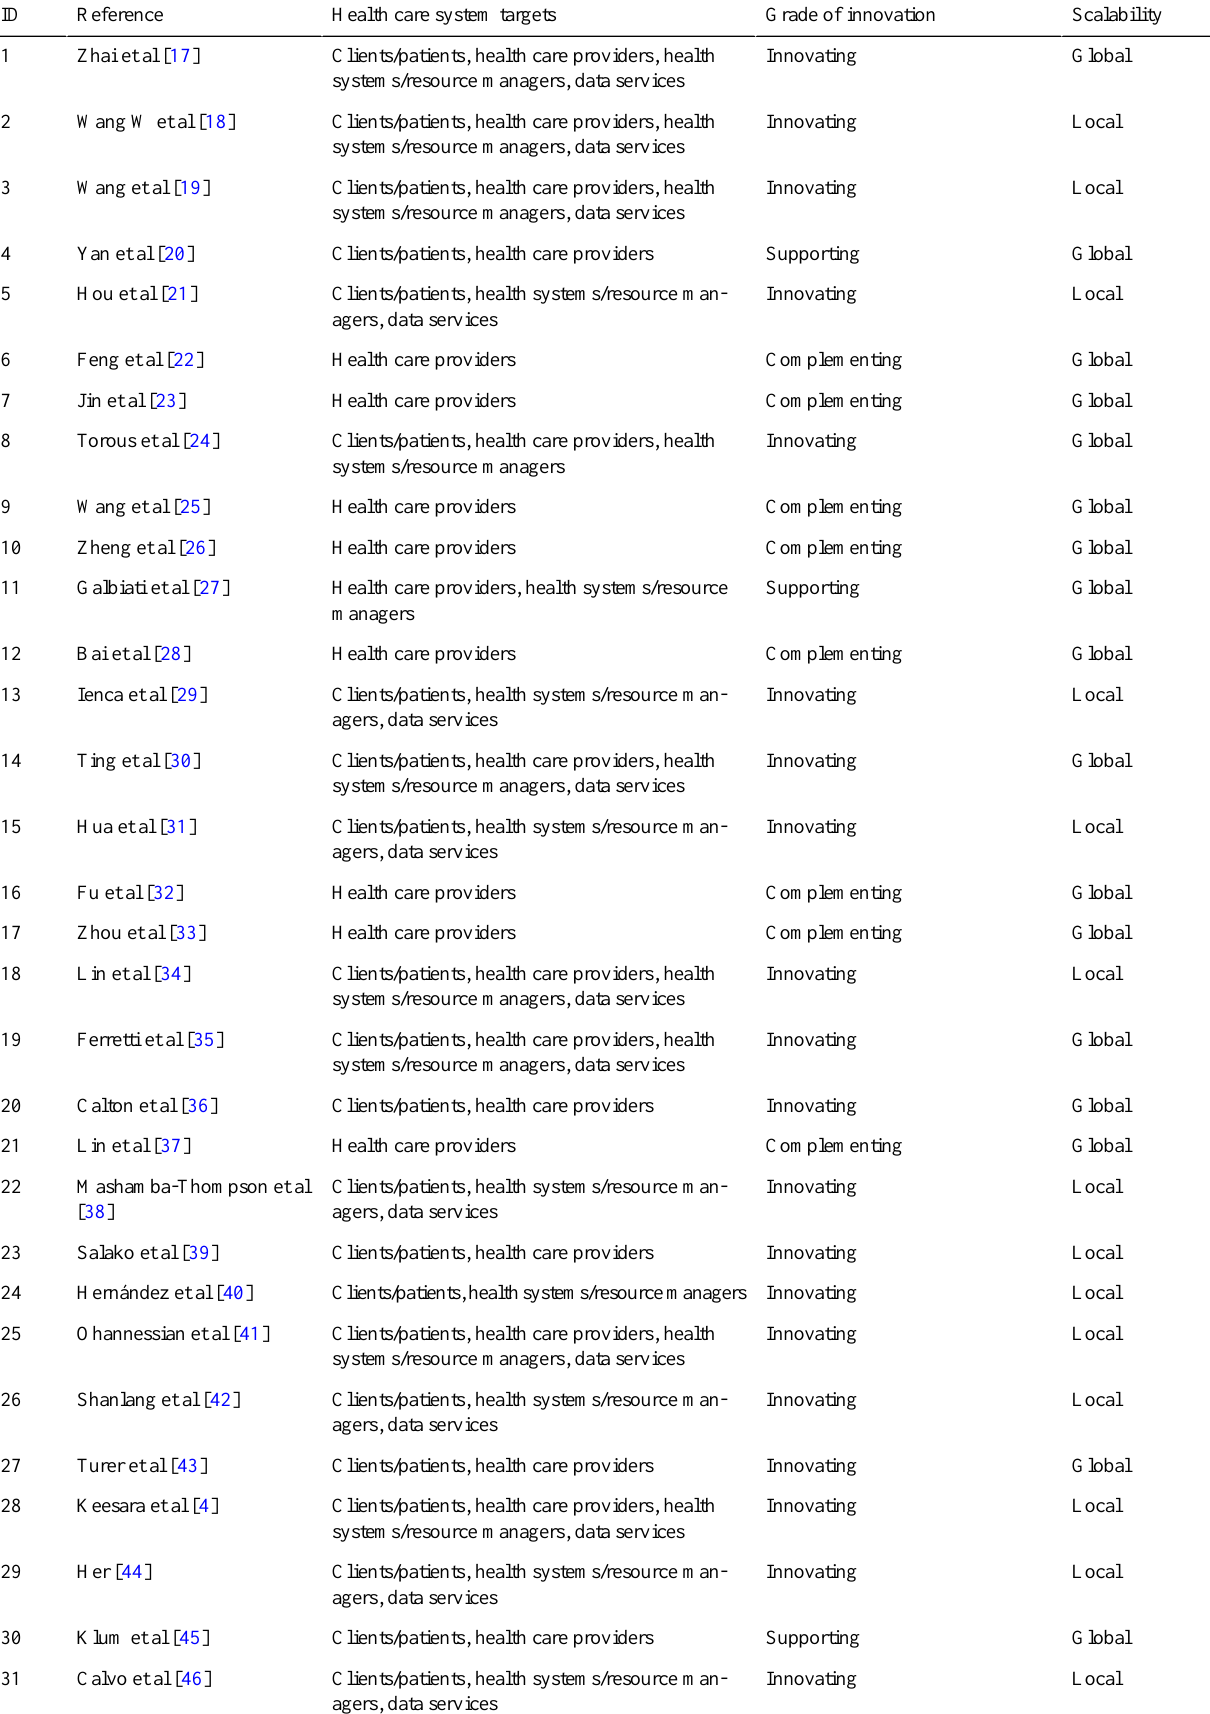
Table 3. Articles included in the literature review with the main characteristics of each analyzed